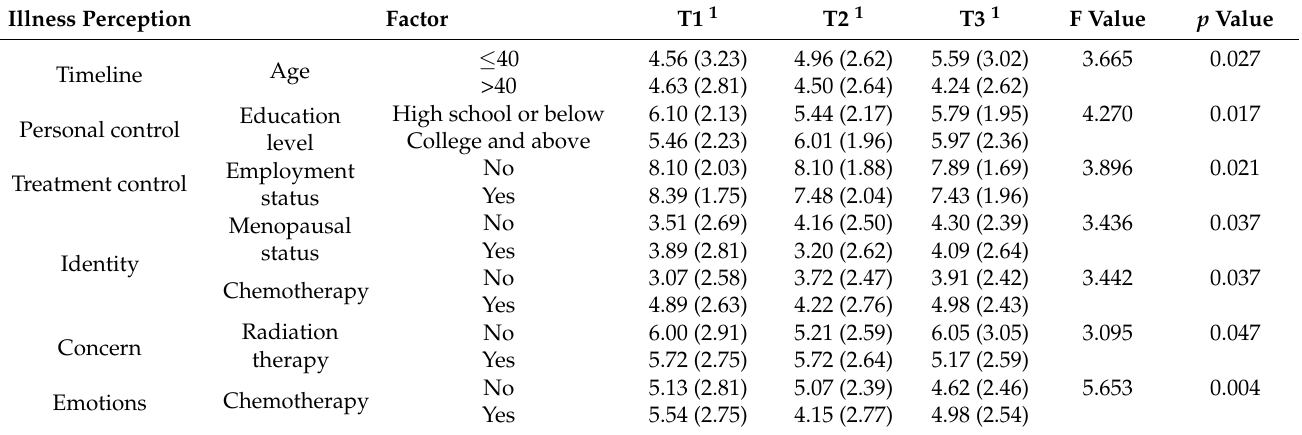
Table 3. The interaction effects of demographic and clinical characteristics on illness perception changes. Illness